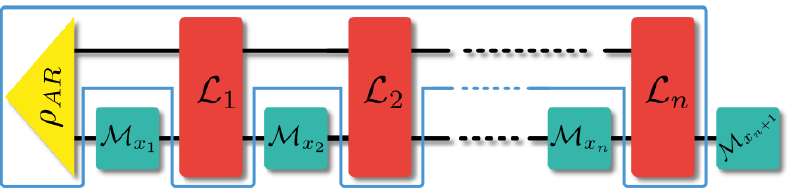
Figure 1: Temporal quantum process. A system of interest is probed sequentially at times t , t ,.... Initially, the system can be in a state ρ 1 2 degrees of freedom (labelled by R ) that are outside the experimenter’s control. Each measurement corresponds to a map M the environment together undergo a free evolution given by CPTP maps L The resulting process is fully described by a comb T